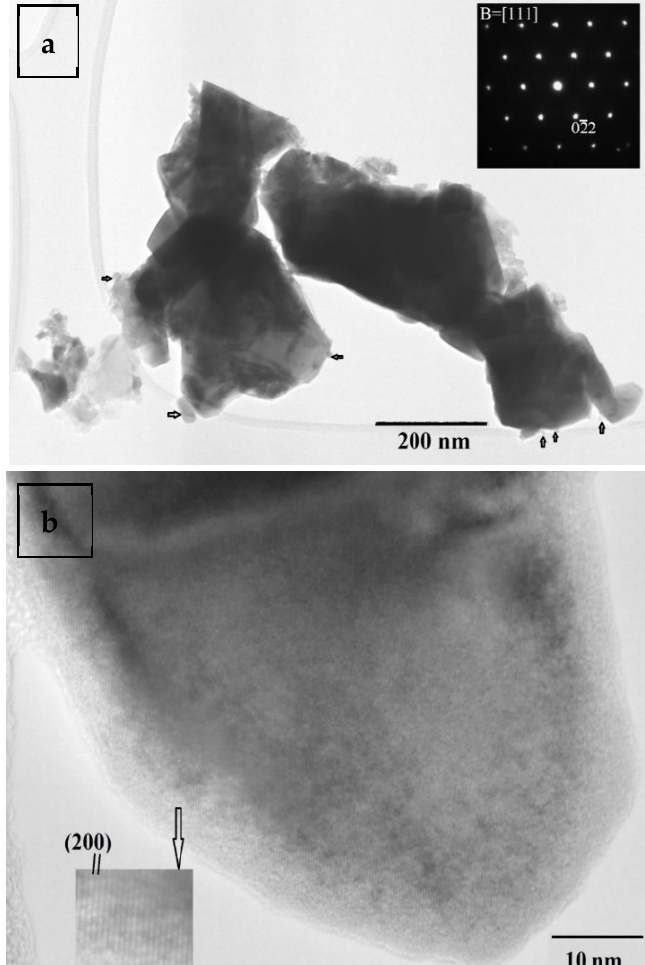
Figure 3. ( a ) TEM image of the particles’ morphology at the Hf 0 . 4 Zr 0 . 2 Ti 0 . 4 CoSb 0 . 8 Sn 0 . 2 sample. The SAD pattern inset, coming from one of these particles, is viewed along [111]. ( b ) HRTEM image of a representative nanocrystalline particle, predominately revealing. Table 3. Nominal and chemical composition of the hot-pressed Hf 0 . 4 Zr 0 . 2 Ti 0 . 4 CoSb 0 . 8 Sn 0 . 2 sample as determined by EDS and TEM.